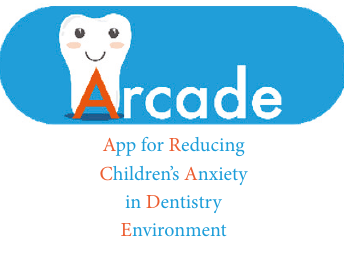
Figure 1: ARCADE project